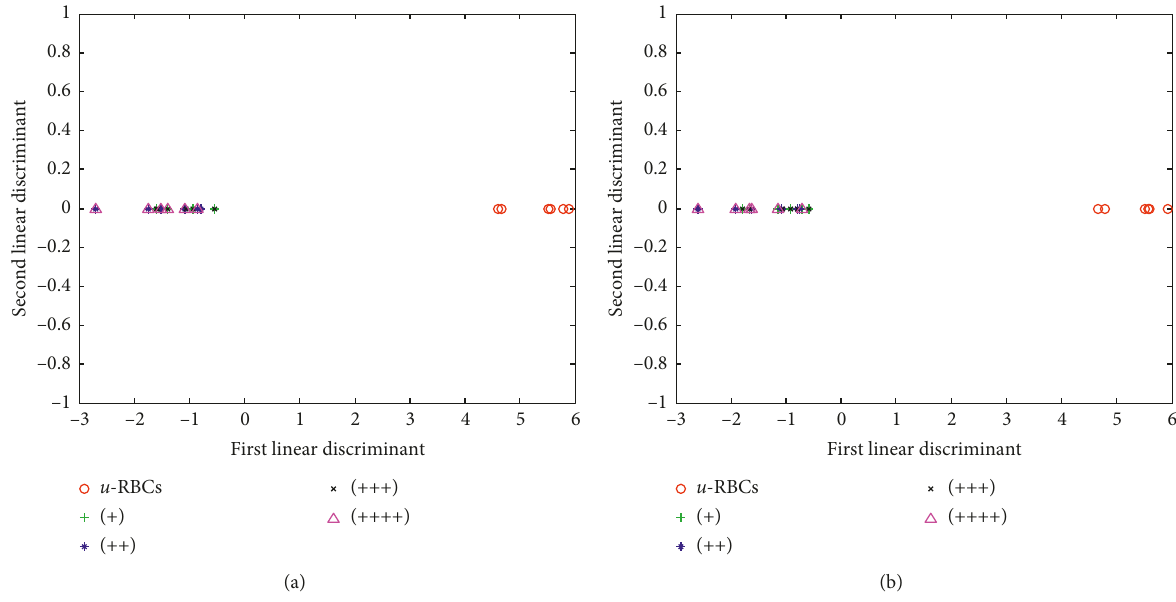
Figure 7: Scatter plots of first and second Fisher’s linear discriminants showing reflected pixel intensities of uninfected red blood cells ( u -RBCs) and Plasmodium falciparum -infected human red blood cells i -RBCs (+) with parasite density: (+), (++), (+++), and (++++) for (a) 435nm and (b) 660nm illumination light sources.